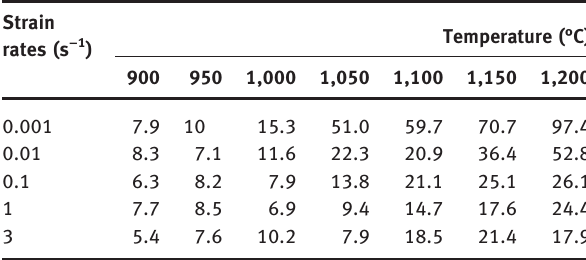
Table 4: Grain size under different deformation conditions ( μ